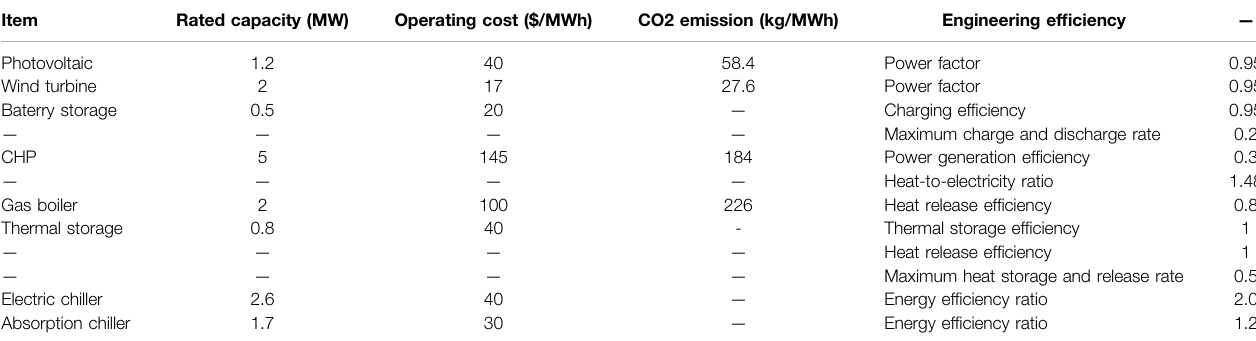
TABLE 1 | Integrated energy system parameters.